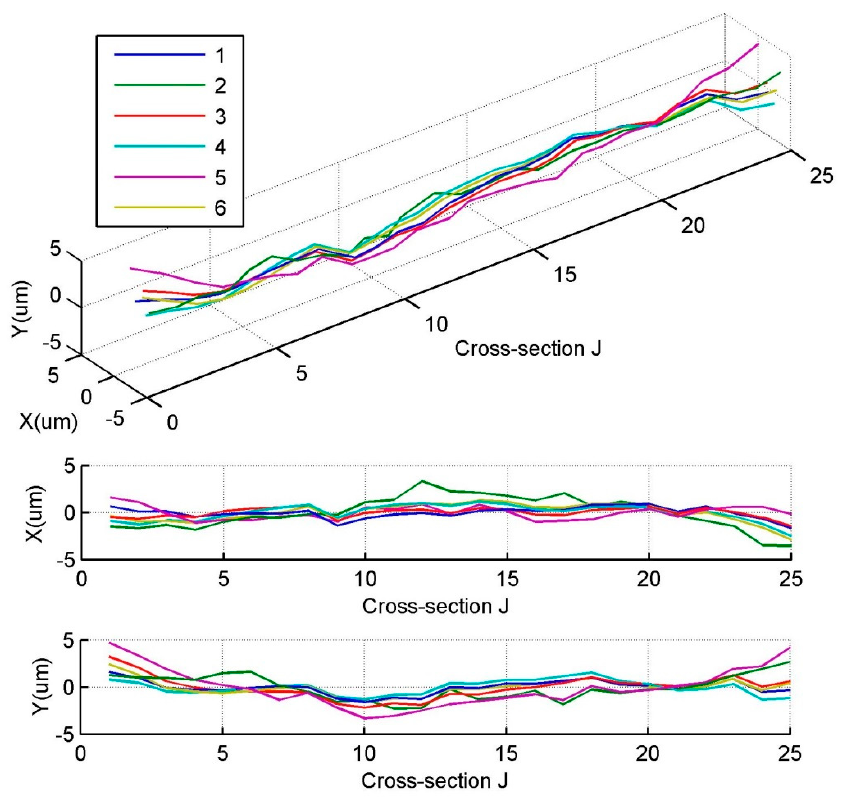
Figure 8. Median line profiles measured by the parallel five-point EST.